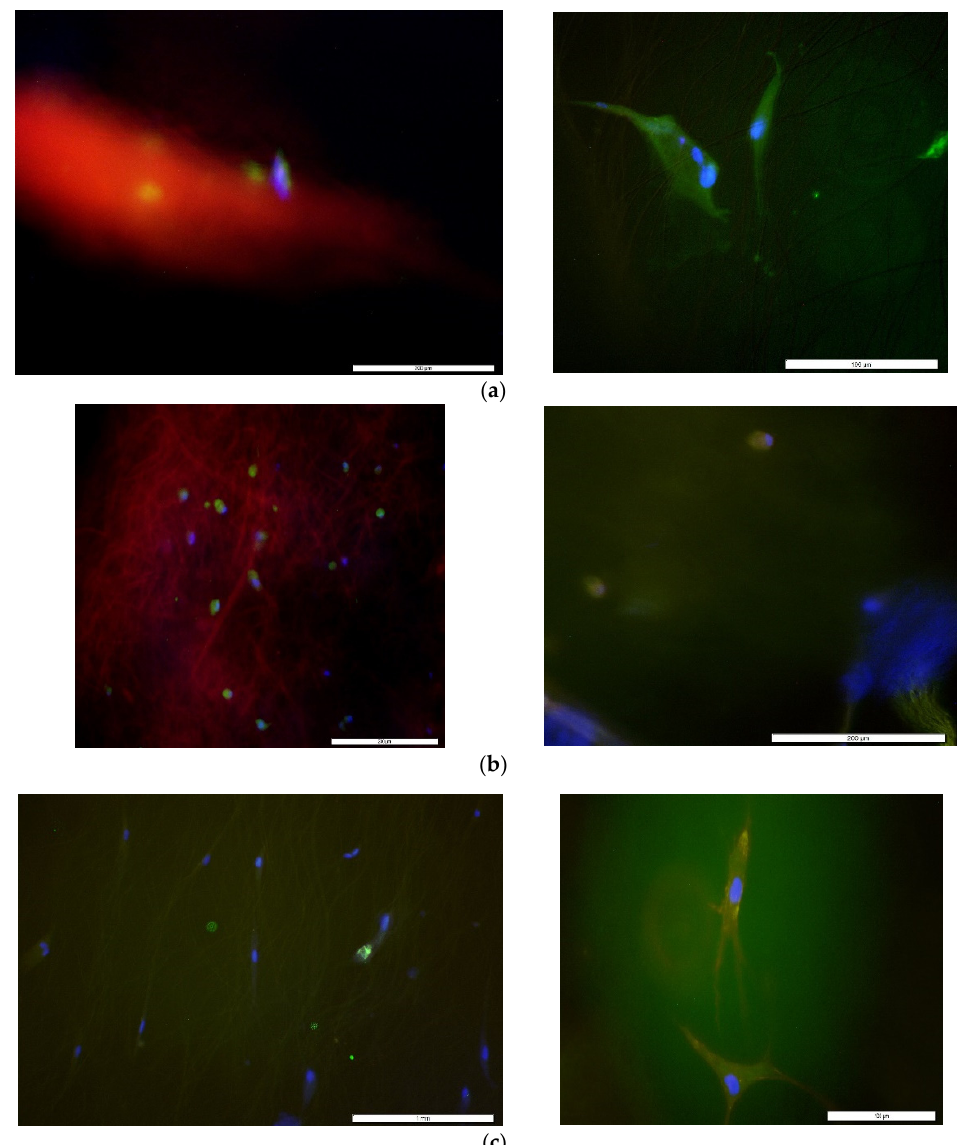
Figure 9. A representative fluorescent stained images (left) showing the existence of stress fibers and elongated cells (right) in ( a ) PEGDA-PCL, ( b ) SA-PCL and ( c ) CG1-PCL dermal equivalent models. All images were captured at 100× magnification. Scale bar in each image is 200 µm.